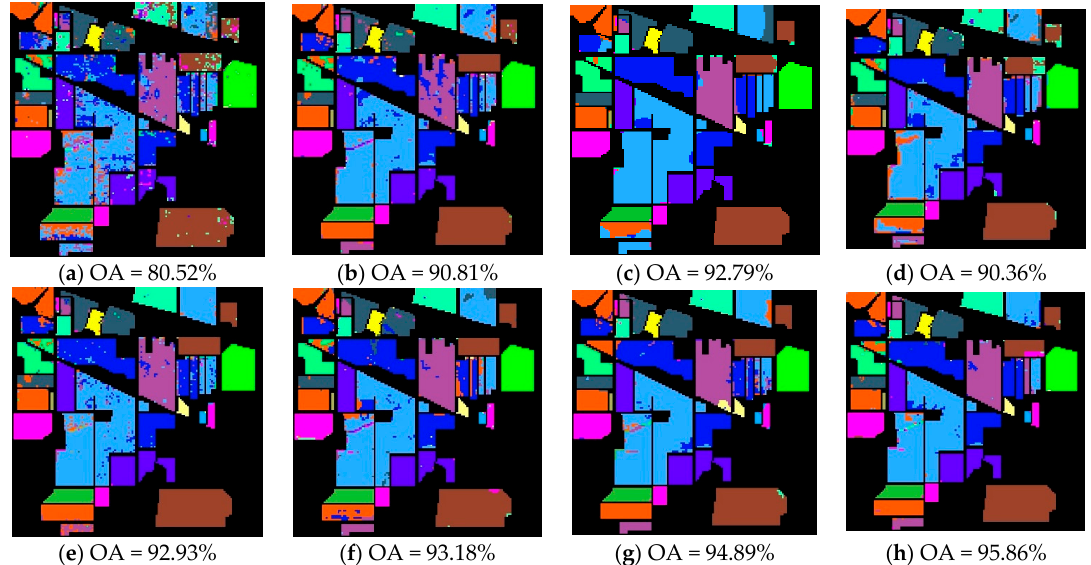
Figure 4. Classification results of the IP image. ( a ) SVM; ( b ) EMP; ( c ) EPF; ( d ) SVM-CK; ( e ) MLR-GCK; ( f ) SC-SSK; ( g ) SC-MK; and, ( h ) SVM-SSHK.